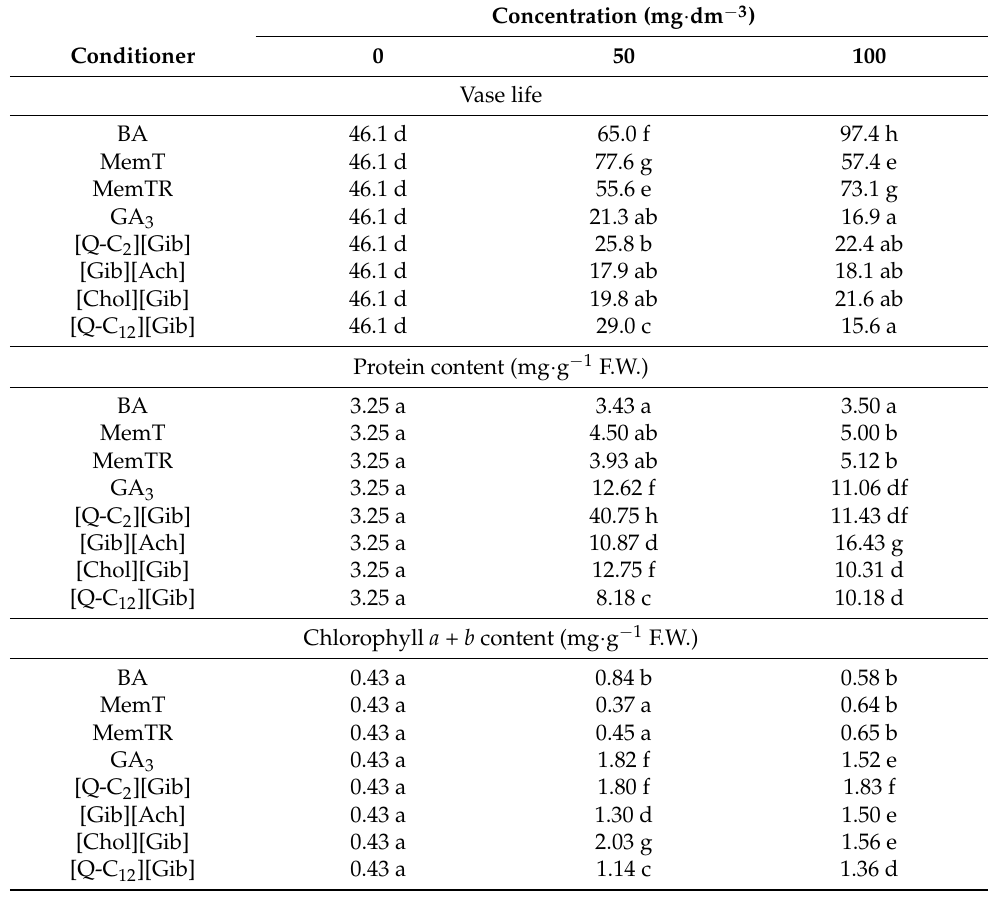
Table 4. Vase life (days) of leaves, protein, and chlorophyll a + b content (mg · g − 1 F.W.) in leaves of Heuchera hybrida ‘Chocolate Ruffles’ depending on conditioner type and concentration. Means followed by the same letter for column-wise and row-wise do not differ significantly at α = 0.05.